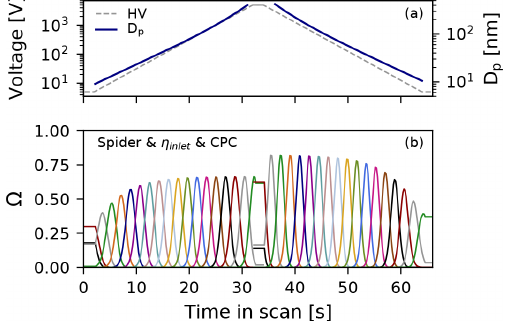
Figure 3. (a) Scanning voltage and classified particle size over the Spider DMA scan. (b) Transfer function of the integrated Spider DMA–MAGIC CPC system (ratio of particle number at the outlet to the inlet), consisting of the Spider DMA scanning transfer func- tion combined with its inlet transmission efficiency and the MAGIC CPC response.